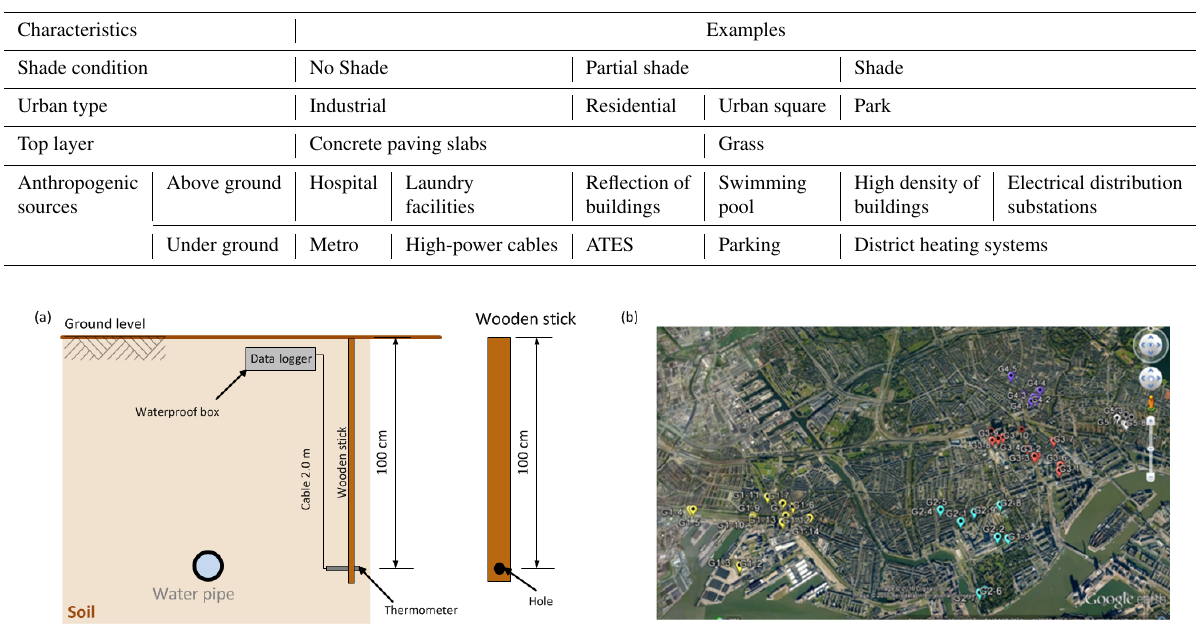
Figure 4. (a) Detail of the soil temperature measurement installation and (b) locations of the measurements (source: Google Earth).